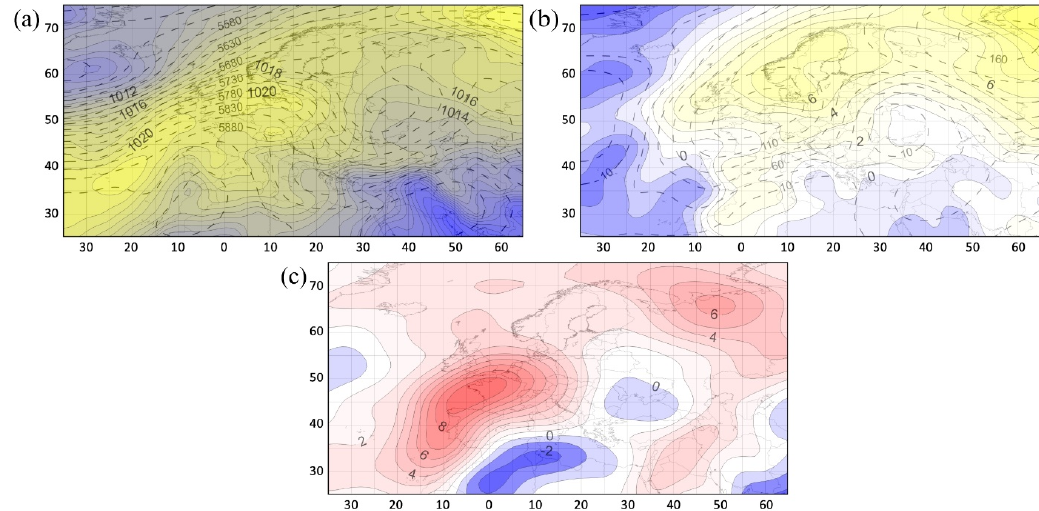
Figure 10. Composites of SLP in hPa (colour scale) and z500 hPa in gpm (dashed lines) ( a ); anomalies of SLP in hPa (colour scale) and z500 hPa in m (dashed lines) ( b ); anomalies of T850 in °C ( c ) for the